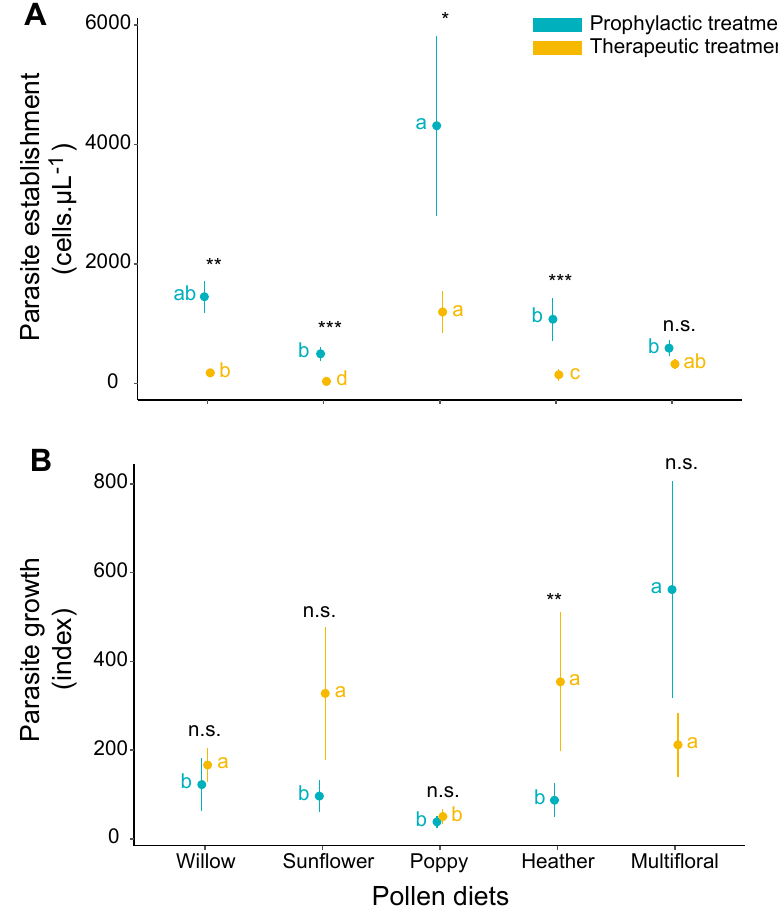
Figure 6. Effects of treatments on host tolerance in B. terrestris microcolonies. ( A ) Effect on parasite establishment (i.e., three days after inoculation), ( B ) Effect on parasite growth. Data in blue represent prophylactic treatments, and data in gold represent therapeutic treatments. Points are mean values of each treatment and error bars indicate the standard error of means. Letters indicate significance at p < 0.05; blue letters refer to comparisons across pollen within prophylactic treatments, gold letters refer to comparisons across pollen within therapeutic treatments, and statistical significance code refers to comparison between treatments (prophylactic vs. therapeutic) (n.s., p > 0.05; *, p < 0.05; **, p < 0.05; ***, p < 0.001). Pairwise comparisons were performed based on a priori contrasts.